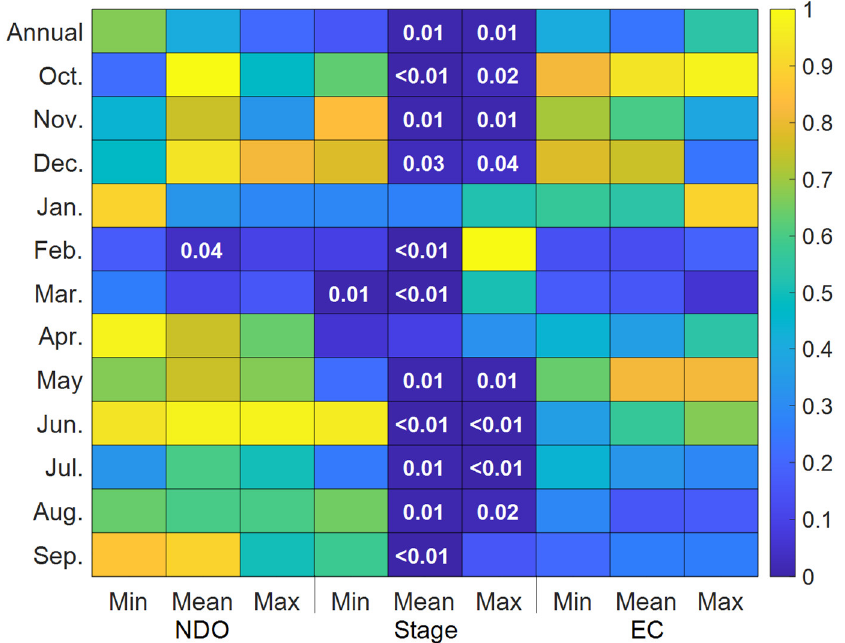
Figure 9. p -values of monotonic trends in minimum (Min), mean (Mean), and maximum (Max), net Delta outflow (NDO), Martinez stage (Stage), and salinity (EC) identified via the Mann–Kendall trend assessment on annual scale and monthly scale. A value less than 0.05 indicates that the trend is statistically significant. The p -values associated with significant trends are specified.